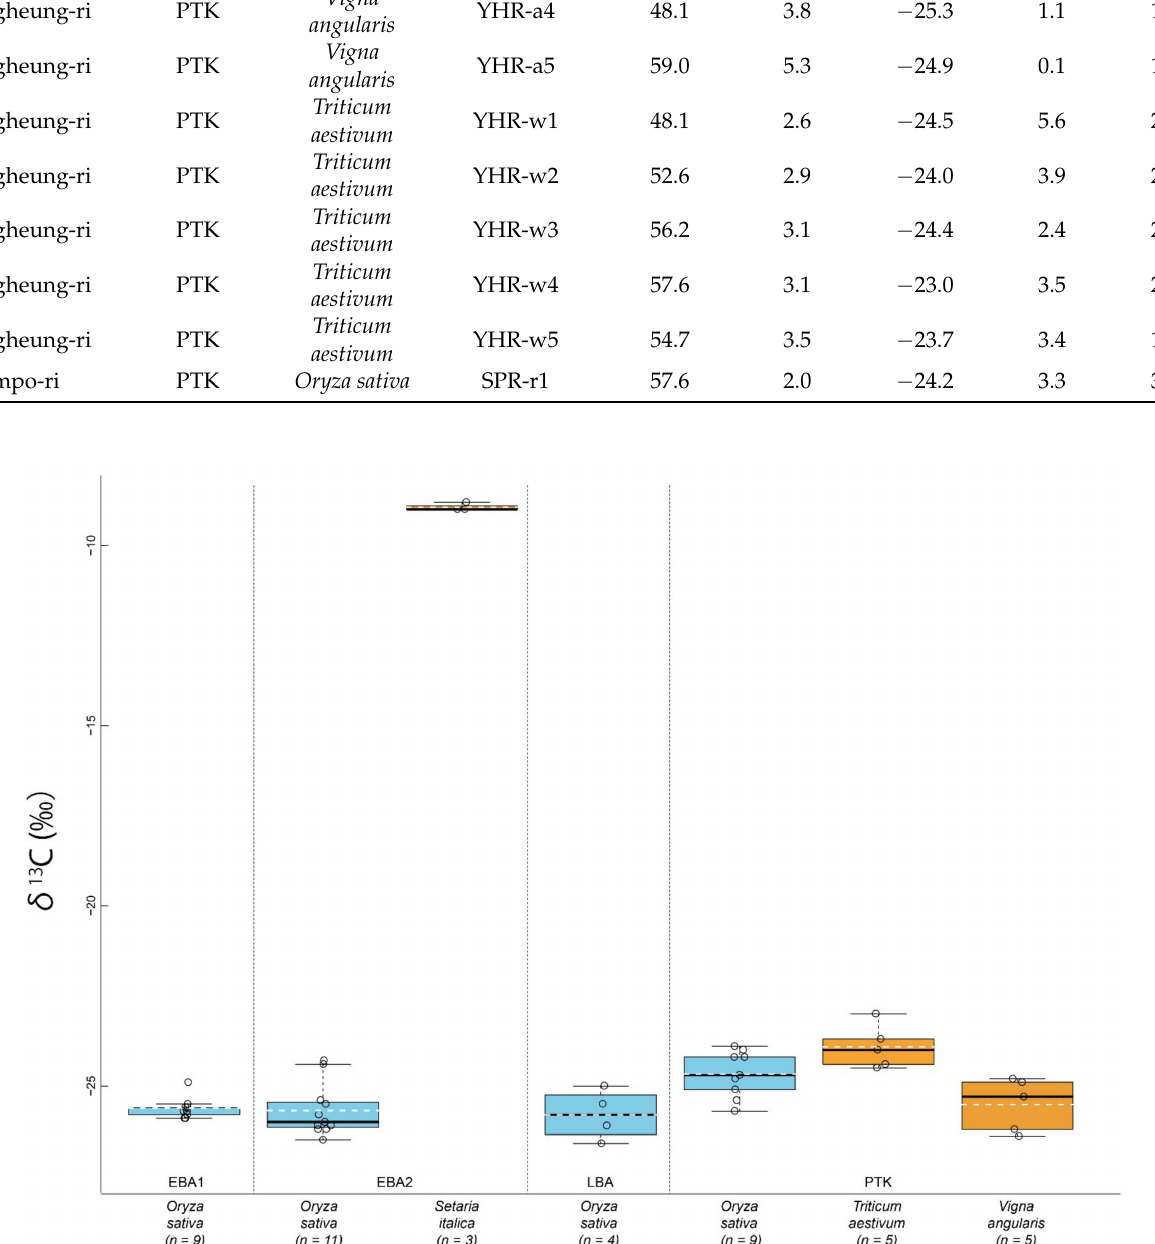
Figure 3. Boxplot comparing carbon stable isotope values among rice, wheat, and azuki bean in each period. Lower and upper box boundaries are 25th and 75th percentiles, error bars are upper extreme and lower extreme, respectively, the lines inside the box are the median, and broken lines are the mean